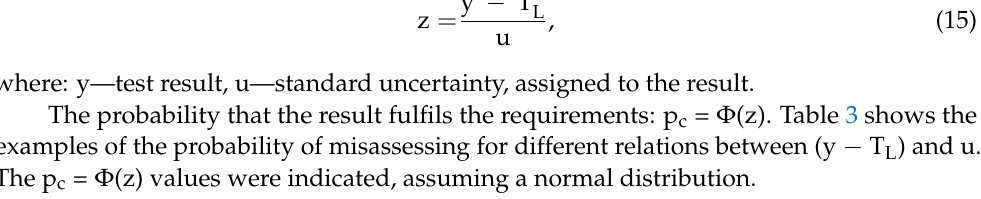
Table 3. Probability values of misassessment, depending on the relationship between (y − T L ) and u. (y − T L )/u p f —Probability of Wrong Decision 3